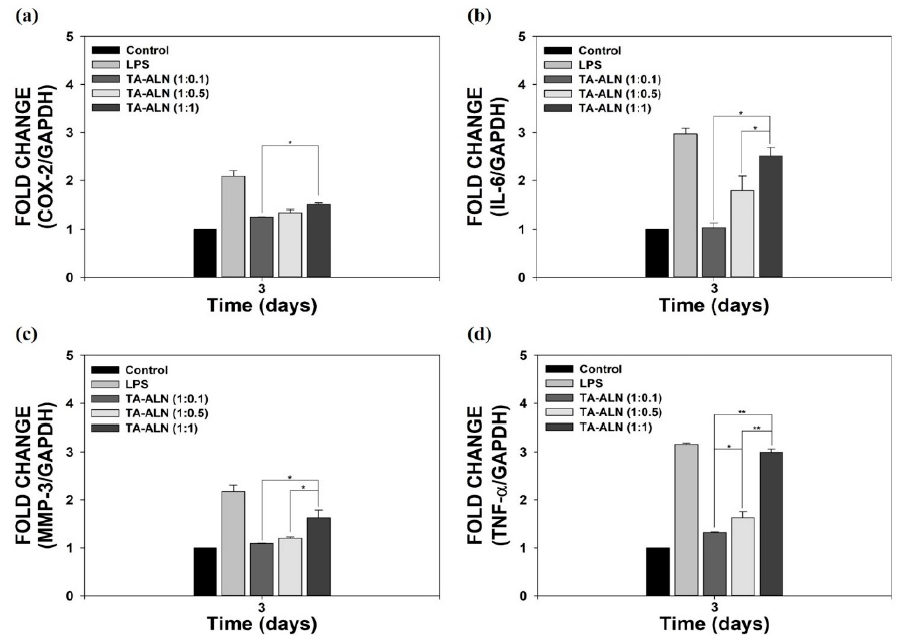
Figure 4. In vitro anti-inflammatory capacities of TA-ALN in inflamed osteoblast-like cells. mRNA levels of pro-inflammatory mediators confirmed by real-time PCR: ( a ) COX-2, ( b ) IL-6, ( c ) MMP-3, and ( d ) TNF- α in LPS-promoted MC3T3-E1 cells on days 3 after treatment with each TA-ALN. The p -value is a comparison between all TA-ALN types. * p < 0.05; ** p < 0.01; GAPDH, glyceraldehyde 3-phophate dehydrogenase; n = 4 per